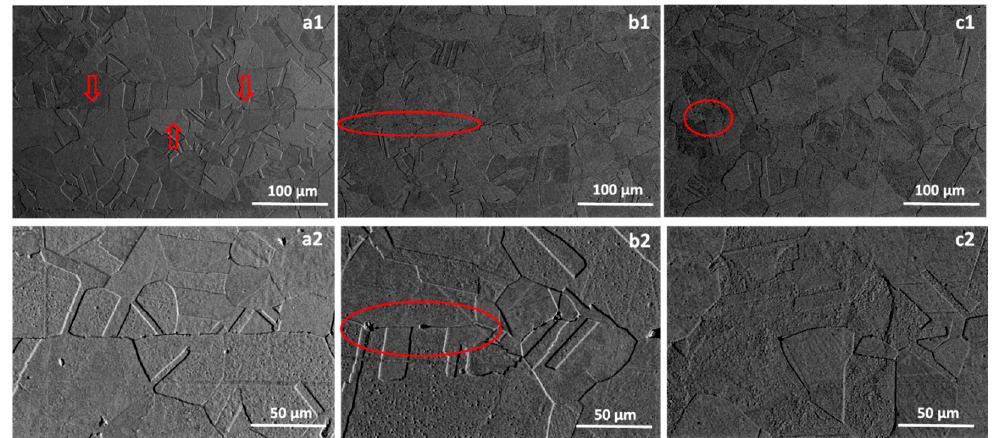
Figure 4. SEM micrographs of Cu-Cu bond cross sections presenting the interfaces between the copper layers. Bonding conditions: sample ( a ) 750 °C/90 min, sample ( b ) 935 °C/90 min and sample ( c ) 1000 °C/90 min.